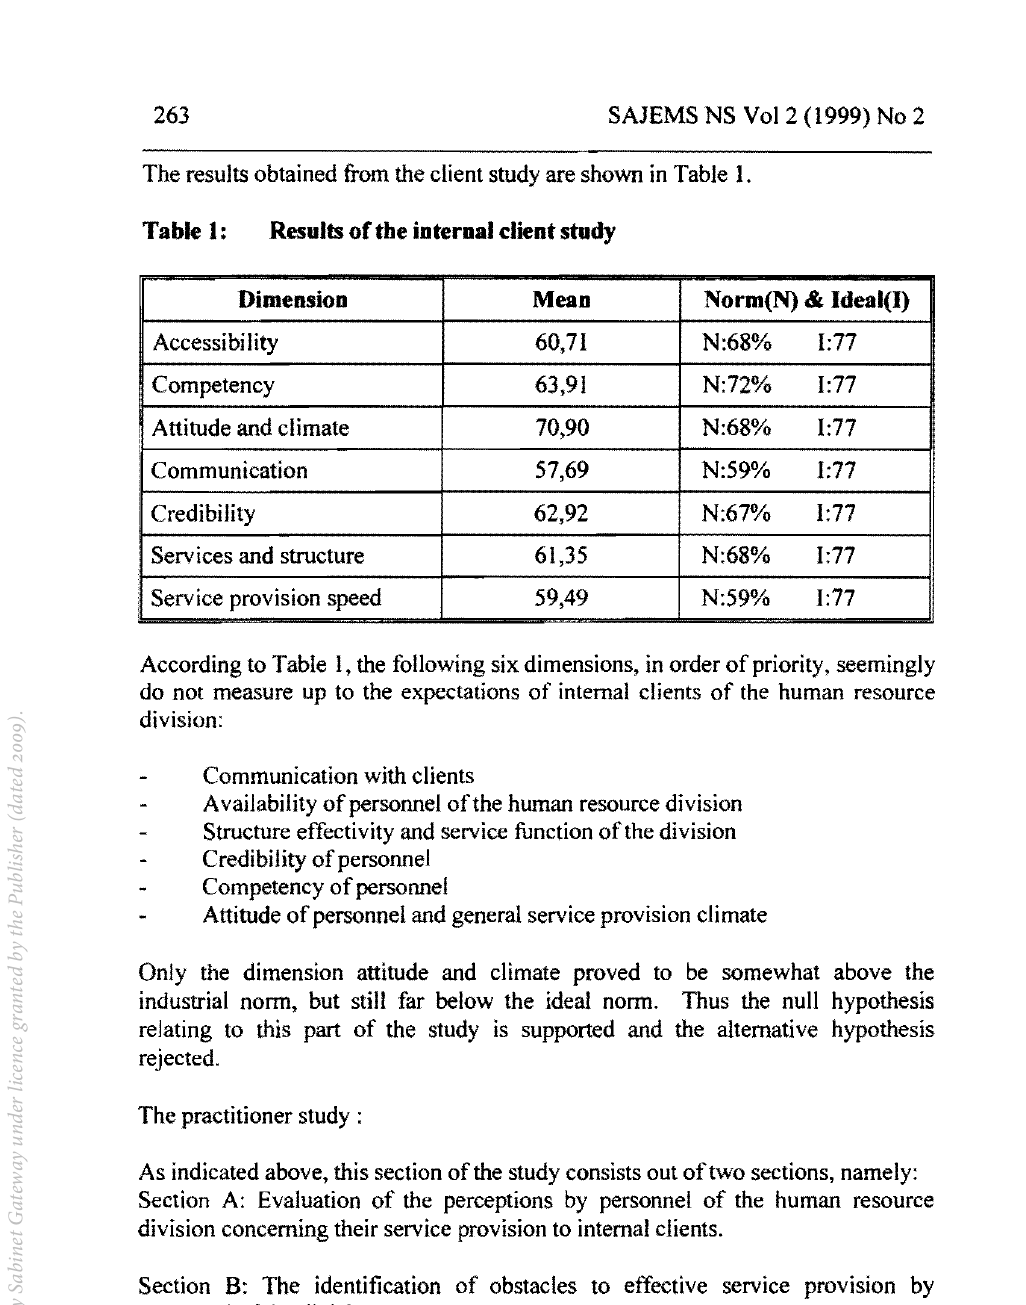
Results of the internal client